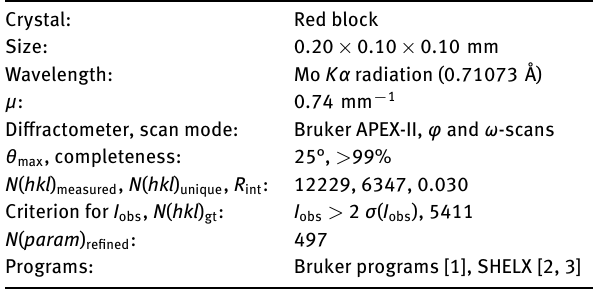
Table 1: Crystal collection and